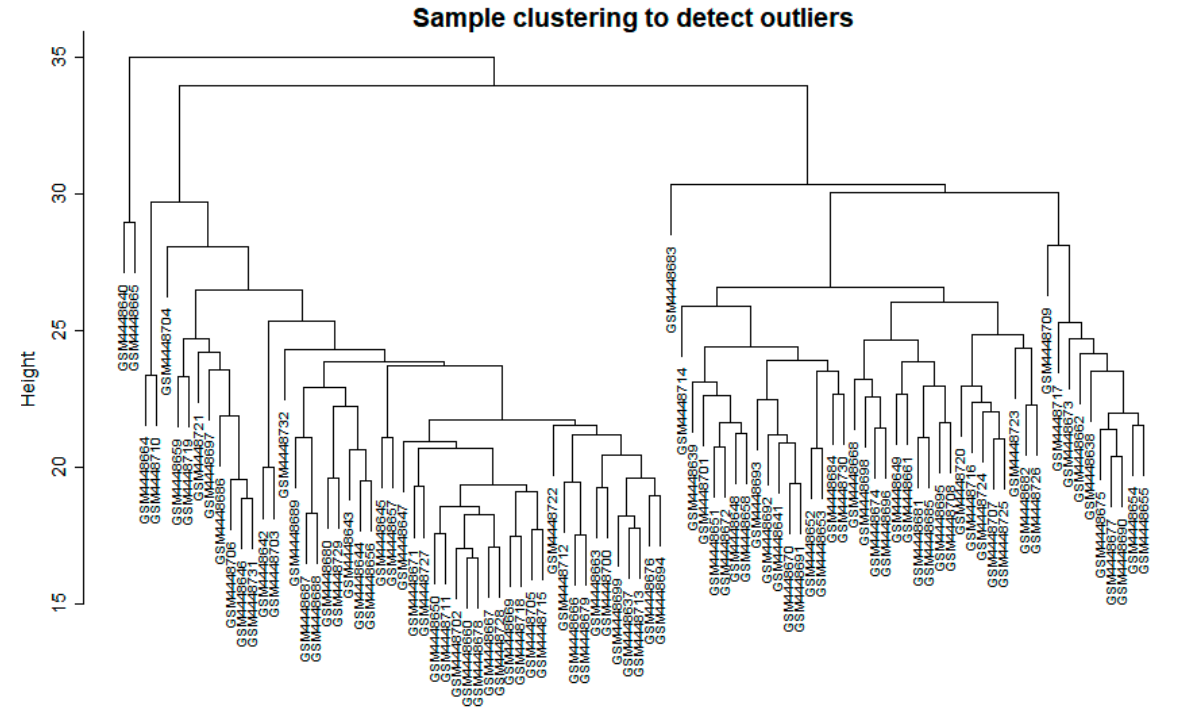
Figure 1. Clustering dendrogram of samples based on their Euclidean distance to detect outliers.